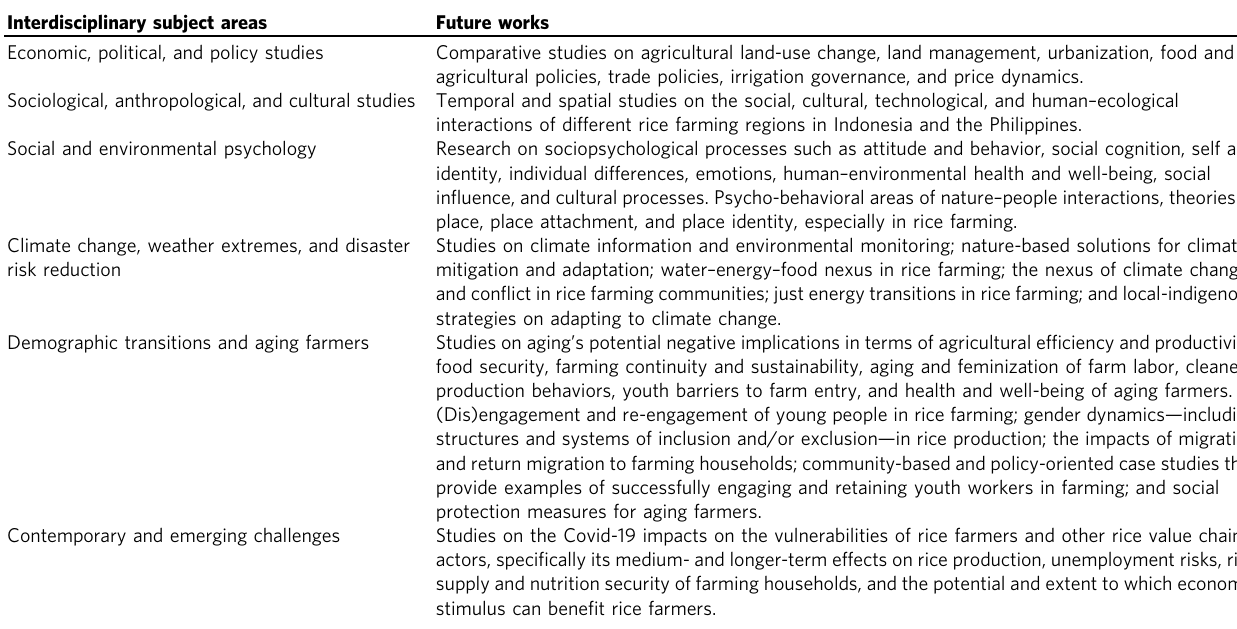
Table 3 A summary of potentially novel research topics across six interdisciplinary subject areas of rice research in Indonesia and the